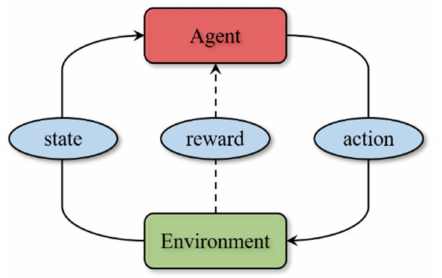
Figure 10. General model of reinforcement